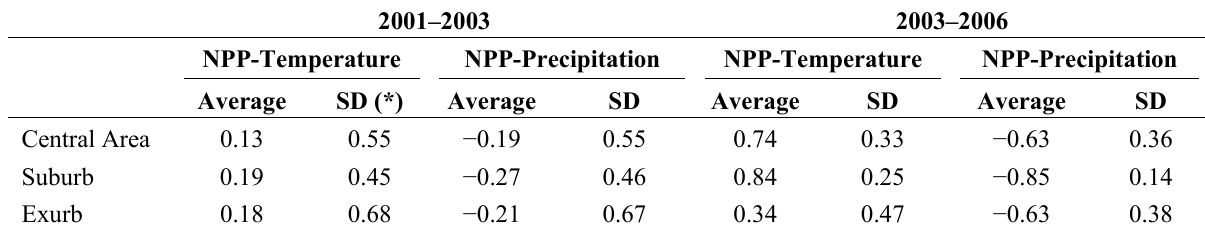
Table 4. Correlations between NPP and temperature and